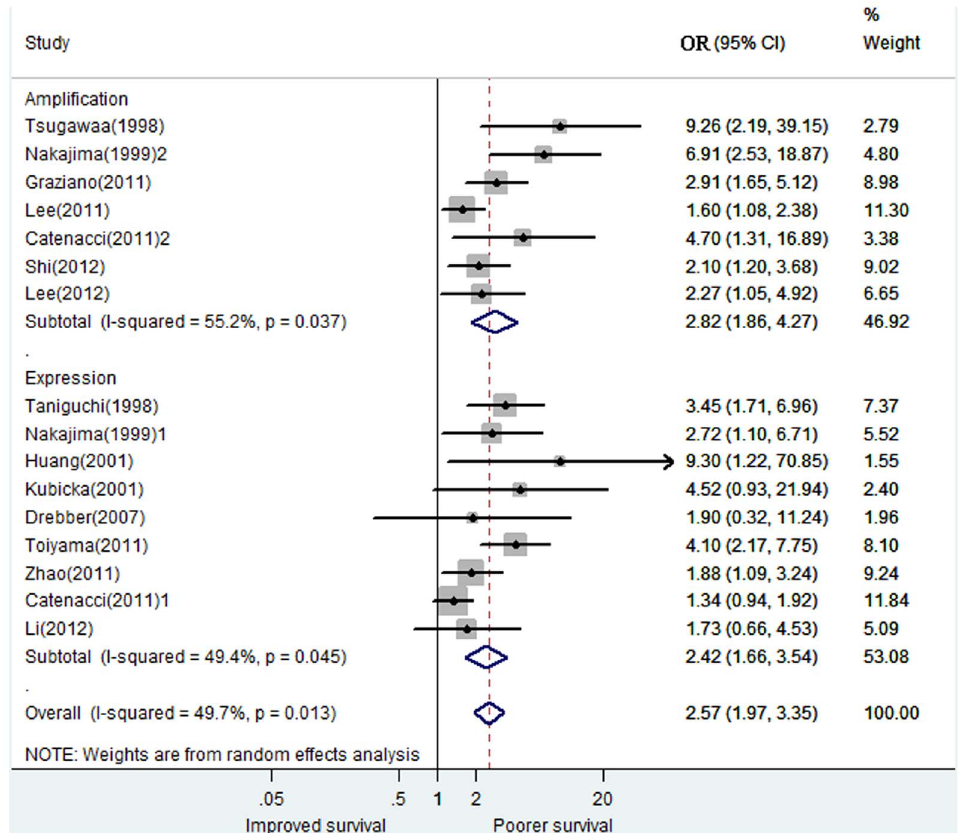
Figure 2. Forest Plot of Results of the Prognostic Value of MET Over-expression. Influence of MET amplification or expression on prognosis in all patients with gastric cancer. Weights are from random-effects analysis. Squares indicate the point estimates of the effect of disease (odds ratio) and diamonds, the summary estimate from the pooled studies; 95% confidence intervals are indicated by horizontal bars and shown in parentheses.